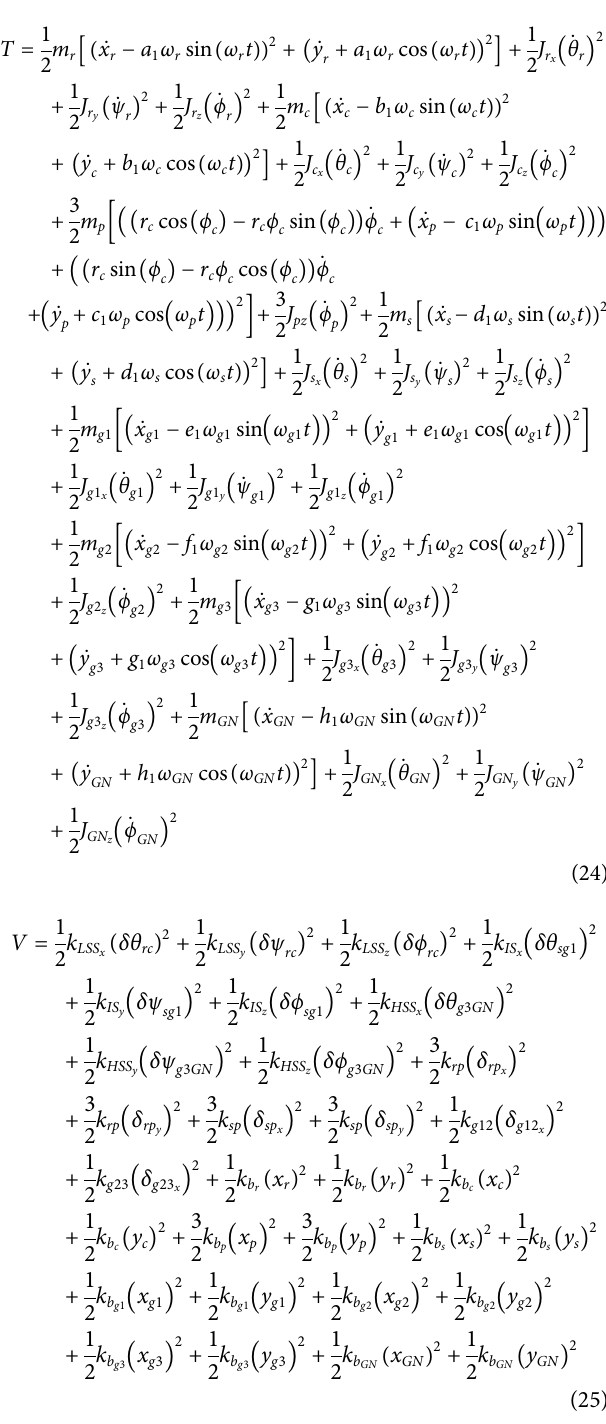
Using the kinetic and potential energy, we can derive Lagrange ’ s equation and the equation of motion ( Eqs 26 , 27 ). Vector Q is a vector of generalized forces. The gravity and non- linear terms are included in vector Q in Eq. 28 . where T , kinetic energy; V , potential energy.